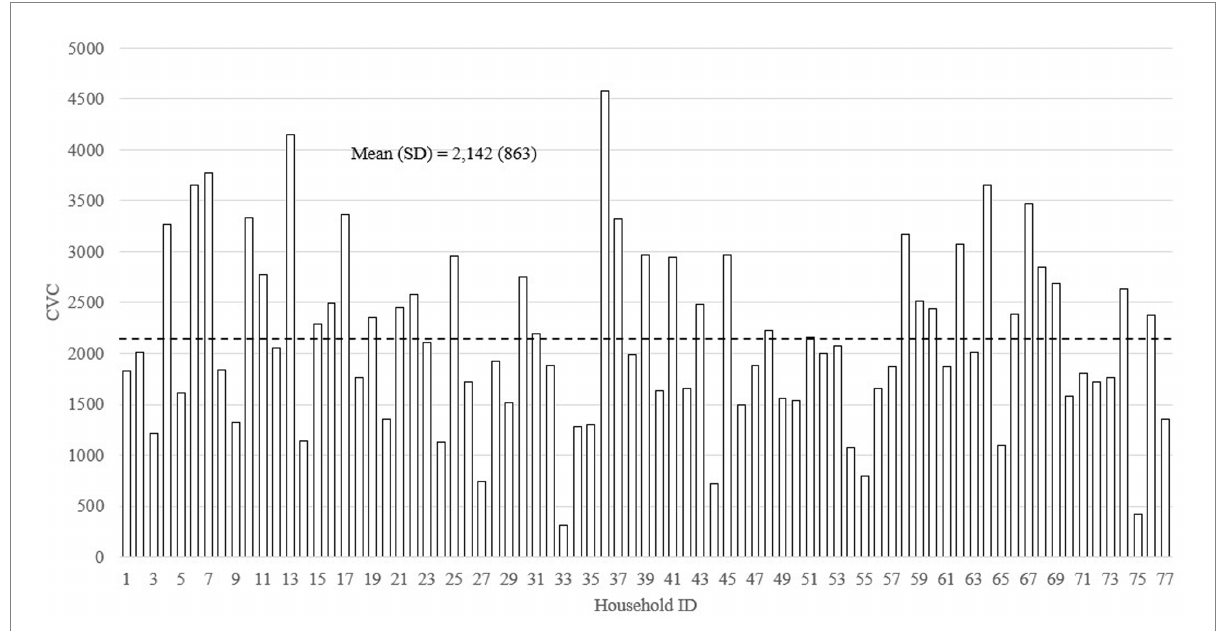
FIGURE 4 The distribution of Child Vocalization Count ( N = 77).